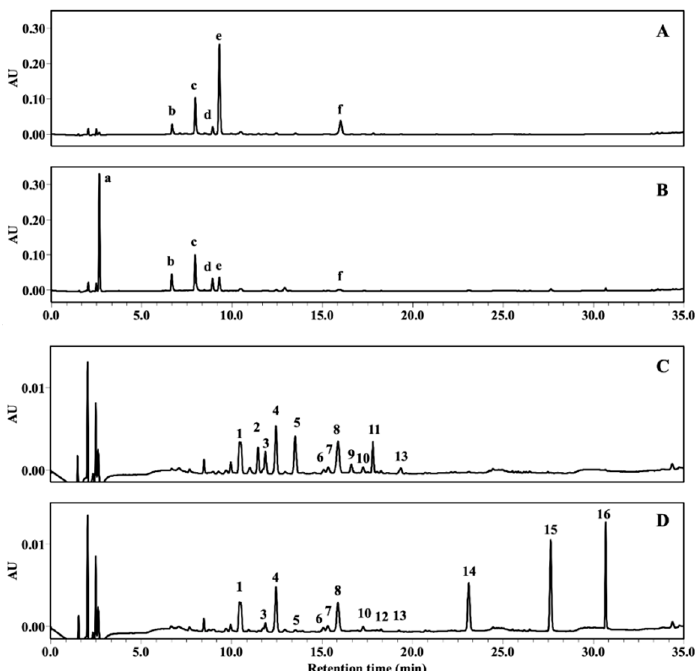
Figure 1. High-performance liquid chromatography traces of green tea extract (GTE) and enzyme-treated GTE. ( A ) Catechin chromatogram of GTE at 275 nm, ( B ) catechin chromatogram of enzyme-treated GTE at 275 nm, ( C ) flavonol chromatogram of GTE at 365 nm, and ( D ) flavonol chromatogram of enzyme-treated GTE at 365 nm. Peaks were identified by mass analysis: a , gallic acid (GA); b , ( ⎯ )-epigallocatechin (EGC); c , caffeine; d , ( ⎯ )-epicatechin (EC); e , ( ⎯ )-epigallocatechin gallate (EGCG); f , ( ⎯ )-epicatechin gallate (ECG). The numbers 1–13, 14, 15, and 16 indicate flavonol glycosides, myricetin, quercetin, and kaempferol, respectively. Refer to the exact mass and structural information of numbered peaks in previous research [30].